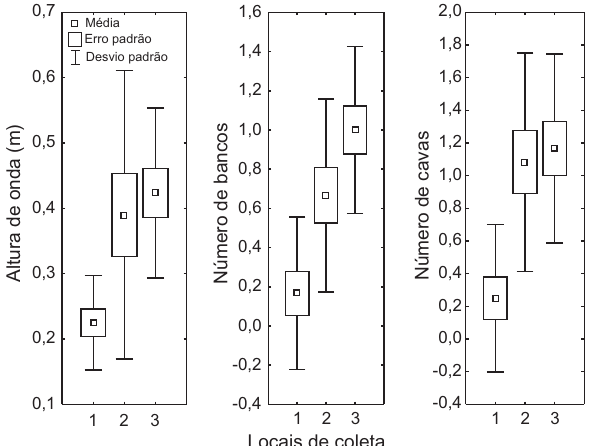
Figura 3. Variação da altura de onda, número de bancos e cavas por local de